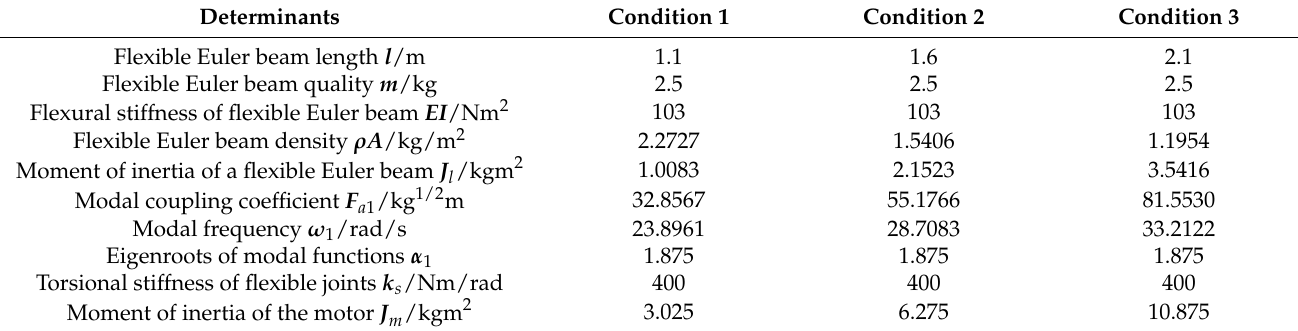
Table 2. System parameters of two flexible bodies under different